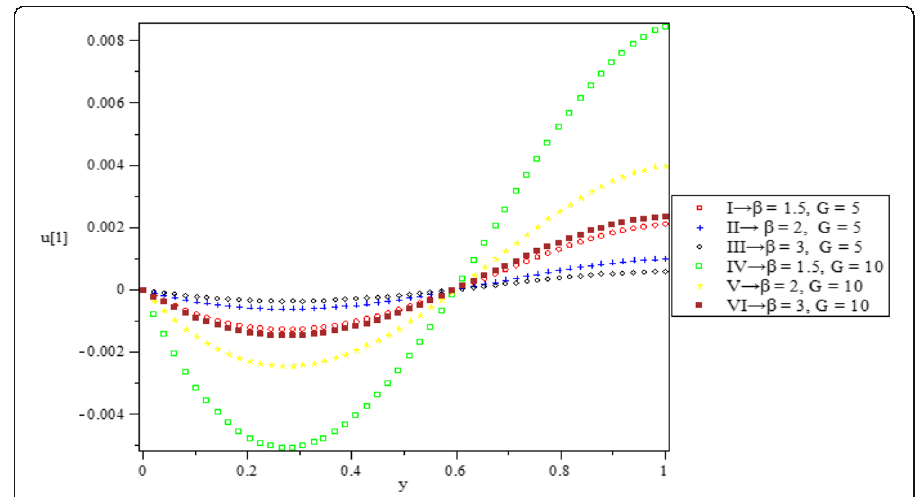
Fig. 15 First-order velocity (u[1] profile, r = − 1, ϵ = 0.25, P = 0.71 α = − 5, and λ = 0.01)